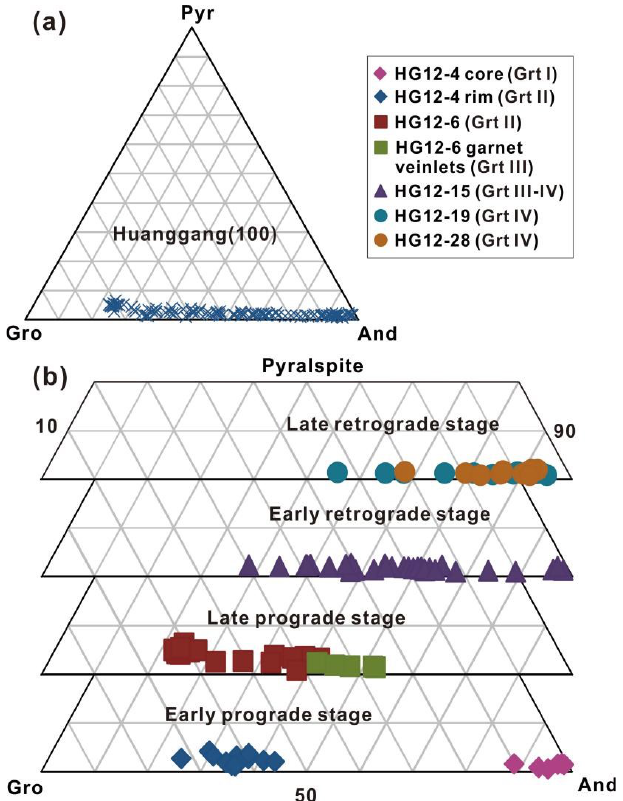
Figure 7. Major element compositions of the garnets from the Huanggang deposit. ( a ) Ternary dia- gram summarizing approximately 100 data of the garnets. ( b ) Ternary diagram summarizing the compositional variations in garnets from the prograde skarn stage to the retrograde skarn stage. Abbreviations: Gro, grossular; And, andradite; Pyr, pyralspite = pyrope + spessartine + almandine + uvarovite.